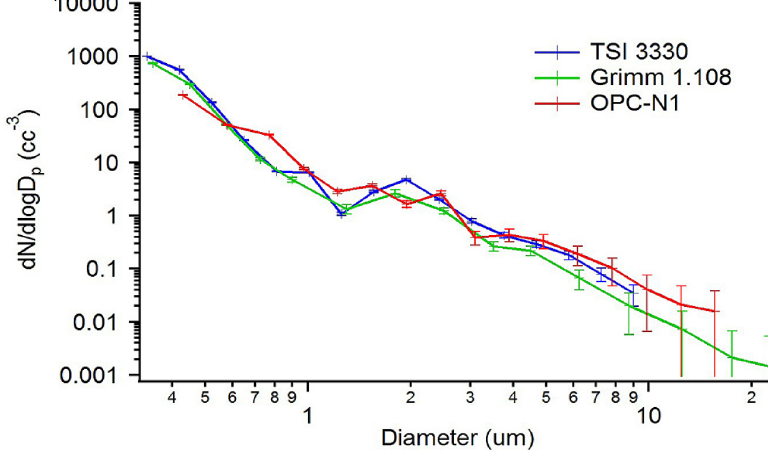
Figure 2. Average measurement error of particle sizes